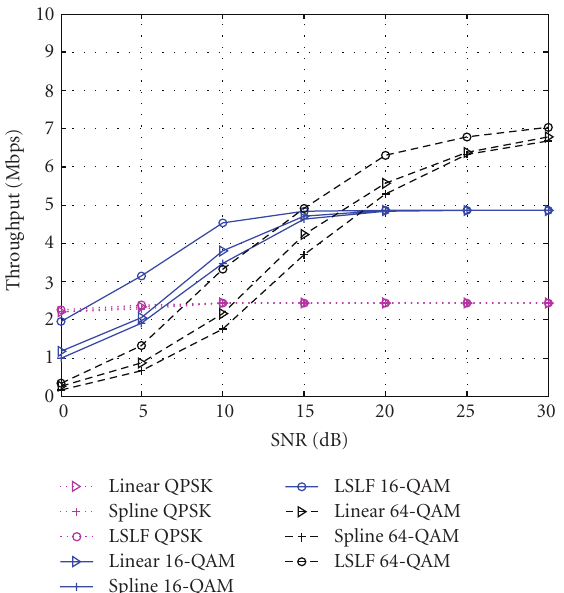
Figure 14: Throughput in Veh.A 120km/h using channel